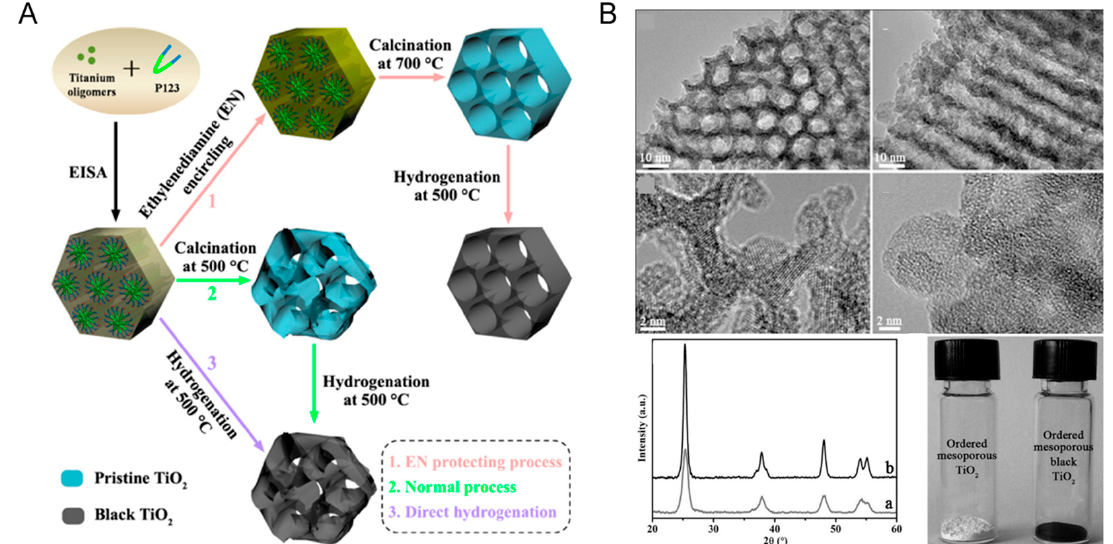
Figure 3. ( A ) Schematic synthesis process for the ordered mesoporous black TiO 2 materials. ( B ) Representative TEM images along [100] and [110] planes, HRTEM images of the ordered mesoporous black TiO 2 materials, and X-ray diffraction patterns and the photos of the ordered mesoporous black TiO 2 materials (a) and ordered mesoporous TiO 2 materials (b). Reprinted with permission for ref. [79]. Copyright 2014, American Chemical Society.